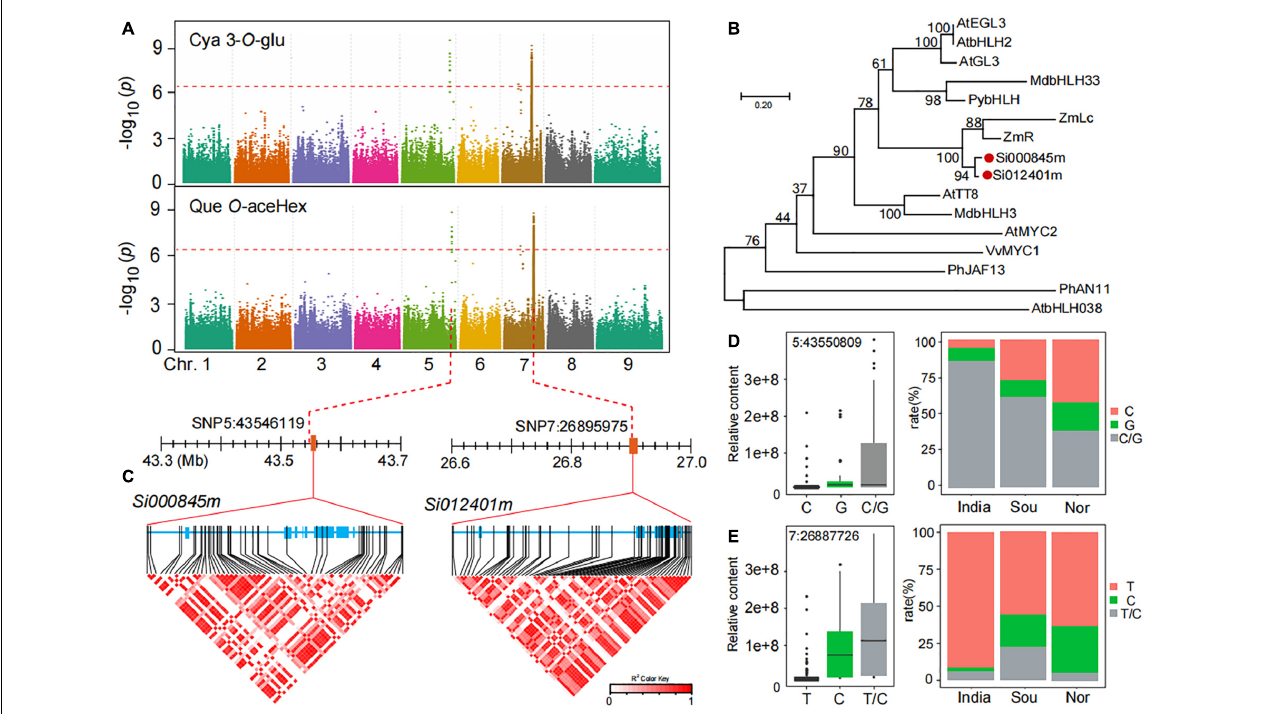
FIGURE 4 | Genome-wide association study of anthocyanins and flavonols in millet. (A) Manhattan plots of mGWAS results of cyanidin 3- O -glucoside (Cya 3- O -Glu) and quercetin O -acetylhexoside (Que O -aceHex) in millet. The strength of association for the metabolites is indicated as the negative logarithm of the p -value for the LMM model. All metabolite-SNP associations with p -values below 1.8E–06 are plotted against genome location in intervals of 1 Mb. (B) An unrooted phylogenetic tree of the MYC protein was constructed as described in Methods. Bootstrap values > 70% (based on 1000 replications) are indicated at each node (bar: 0.2 amino acid substitutions per site). (C) A representation of pairwise r 2 values (a measure of LD) among all polymorphic sites in Si000845m and Si012401m , where the color of each box corresponds to the r 2 value according to the legend. (D,E) Natural variation of nucleotide polymorphisms identified in the sequences of Si000845m and Si012401m and their allelic frequencies in millet from India, south of China (Sou), and north of China